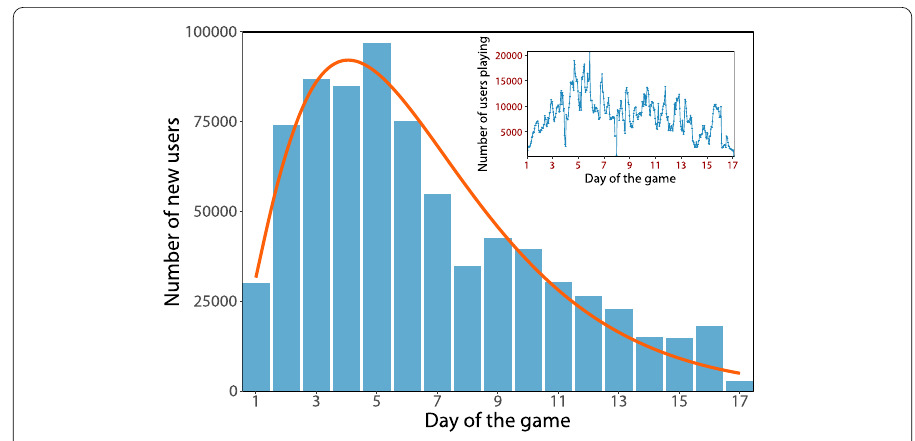
Figure 1 New users per day. The histogram is fitted to a gamma distribution of parameters α = 2.66 and β = 0.41. Note that this reflects those users who inputted at least one command, not the number of viewers. In the inset we show the total number of users who sent at least 1 message each hour, regardless on whether they were new players or